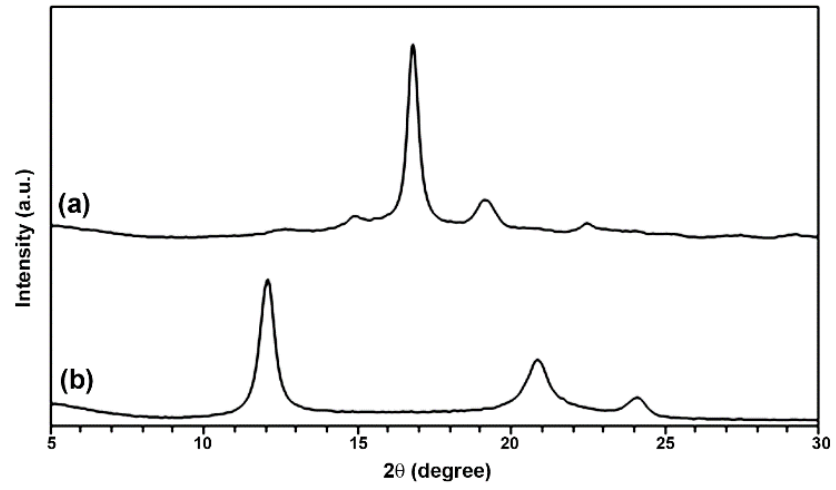
Figure 3. XRD patterns of ( a ) LMW-PLLA and ( b ) scPLA powders.